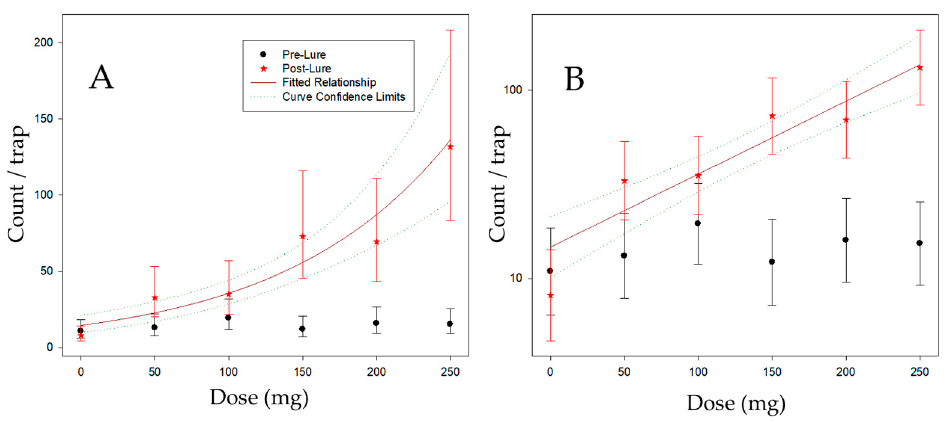
Figure 5. Mean counts of Thrips obscuratus per trap for each dose, pre- and post-lure, with fitted dose-response curve for the post-lure counts recorded after 24 h post lure placement. Error bars / dotted lines are 95% confidence limits for the means / fitted curve. ( A ) On the natural (count scale); ( B ) Y -axis log scaled.